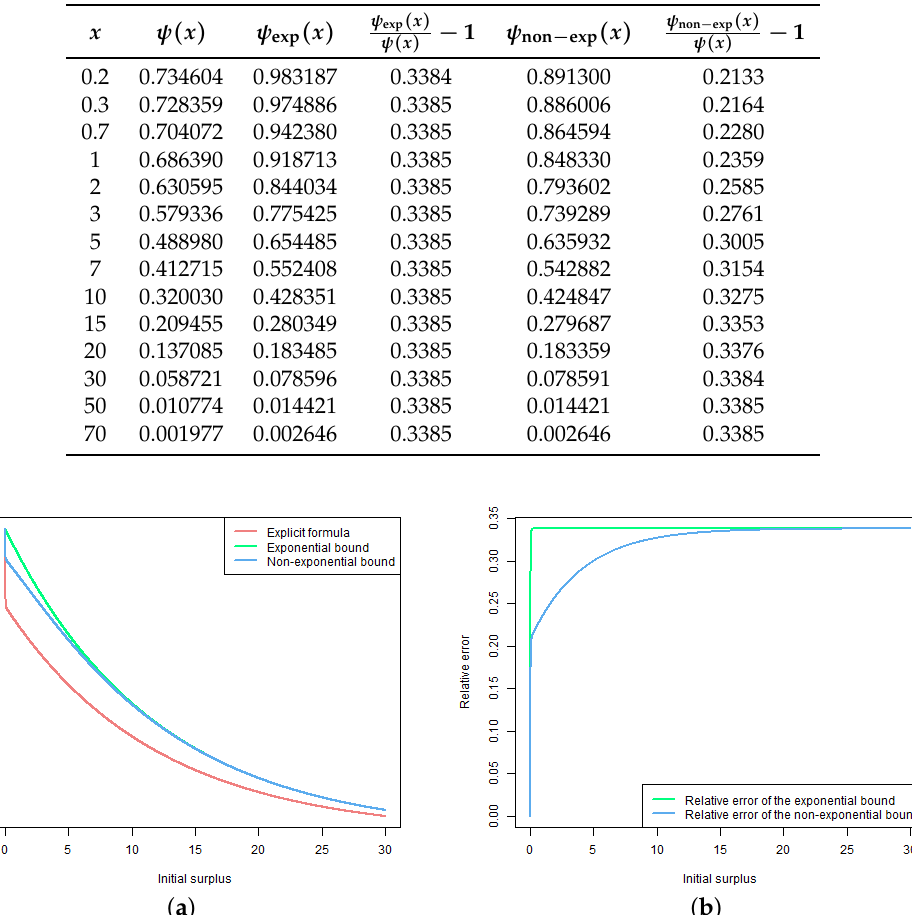
Table 1. Results of computations for the model considered in Example 1.